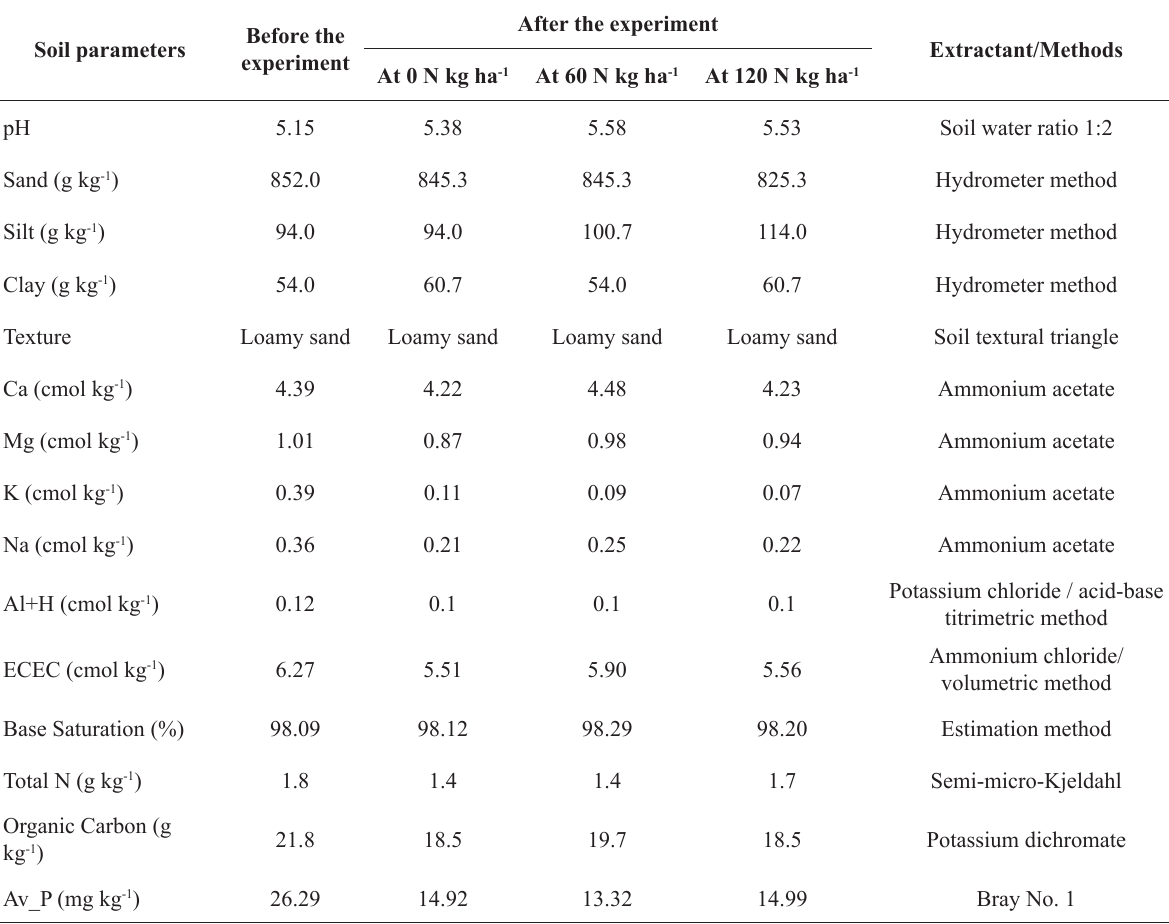
Table 1: Physico-chemical properties of the soil used in the study before and after the